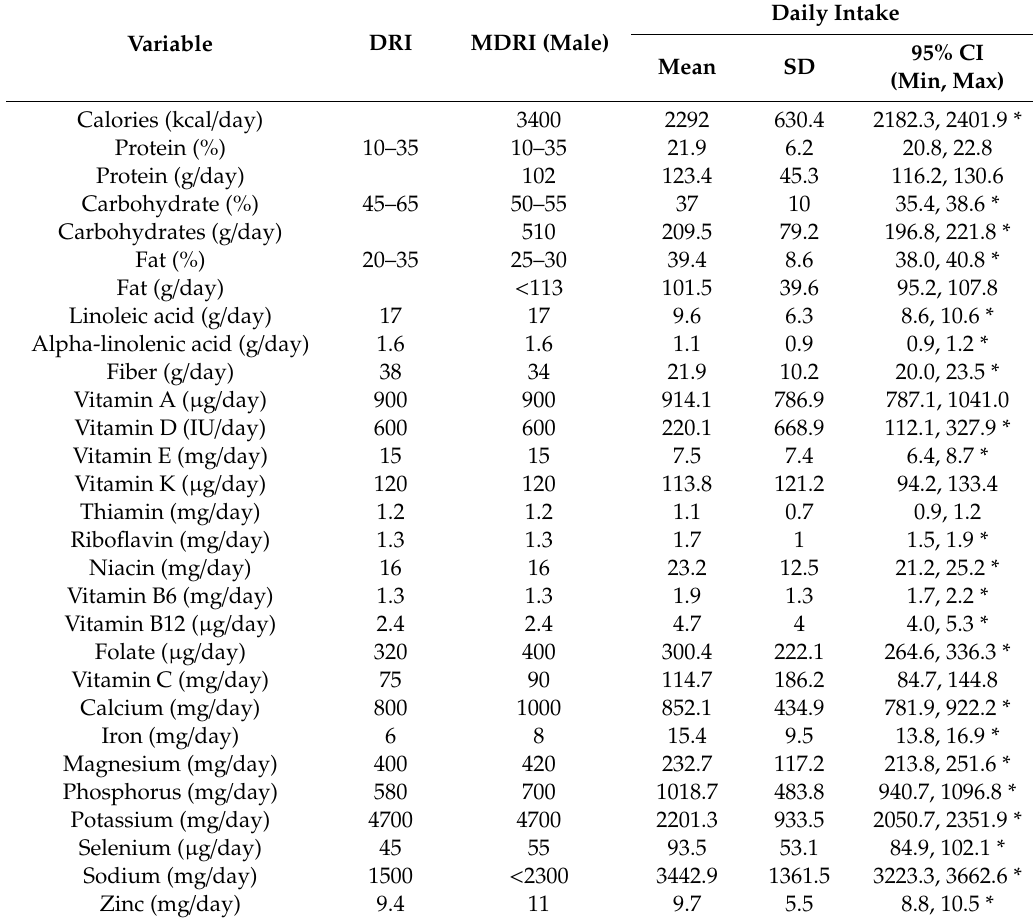
Table 2. Average three-day nutrient intake compared to DRI and MDRI